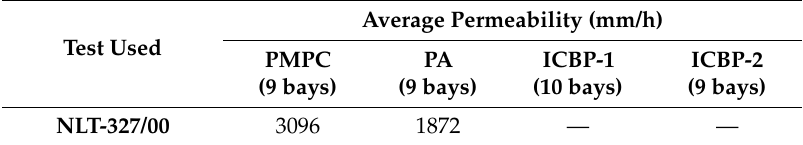
Table 3. Permeability values for the porous-mixture surfaces after five years of